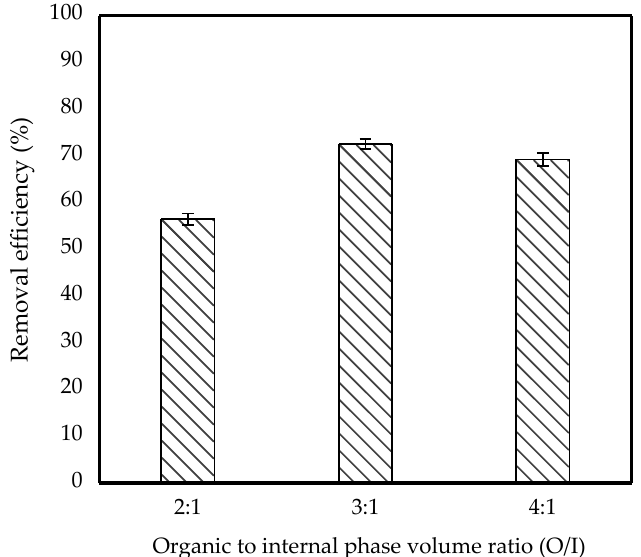
Figure 6. Effect of O/I ratio on removal efficiency of 10 ppm IBP. (Condition: [TOA] = 6 wt%; [Span 80] = 6 wt%; Stirring speed = 300 rpm; Emulsification time = 20 min; Kerosene = 30 mL).